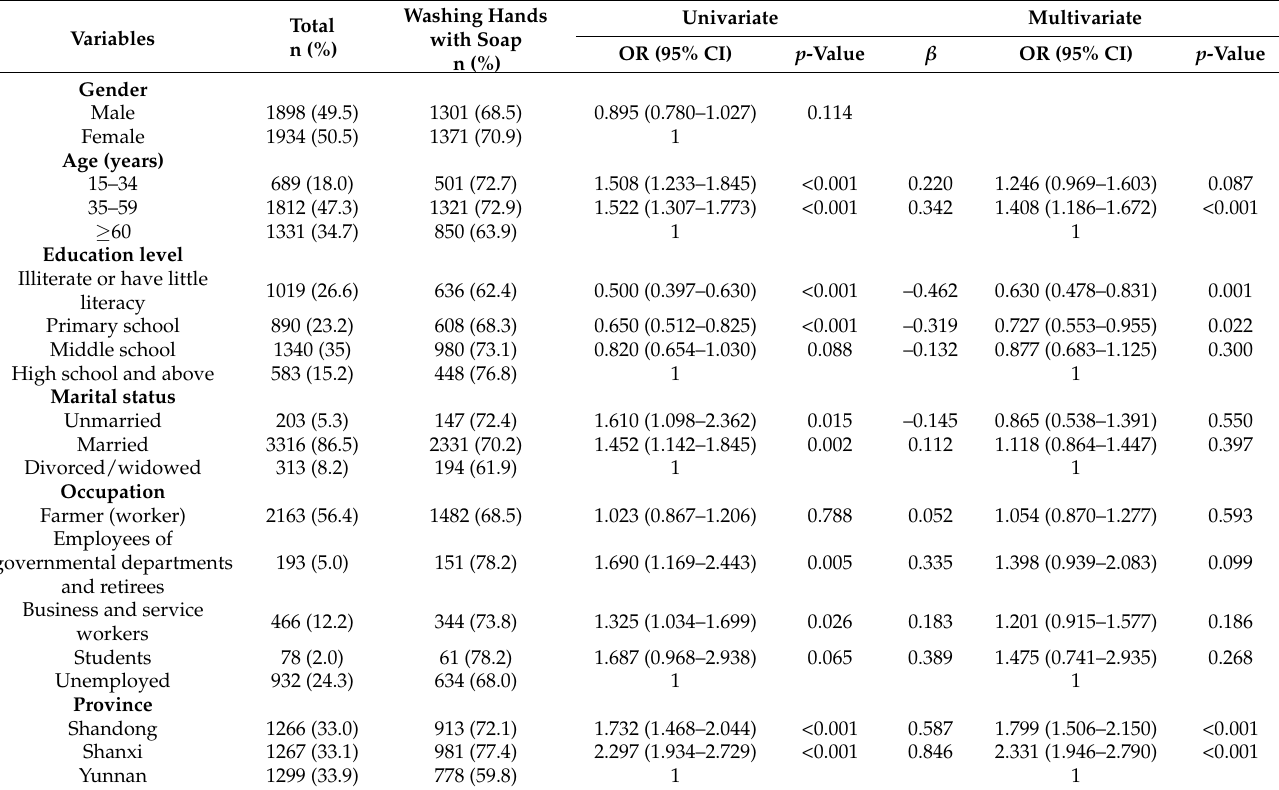
Table 6. Logistic regression analysis for influencing factors of handwashing with soap (n =